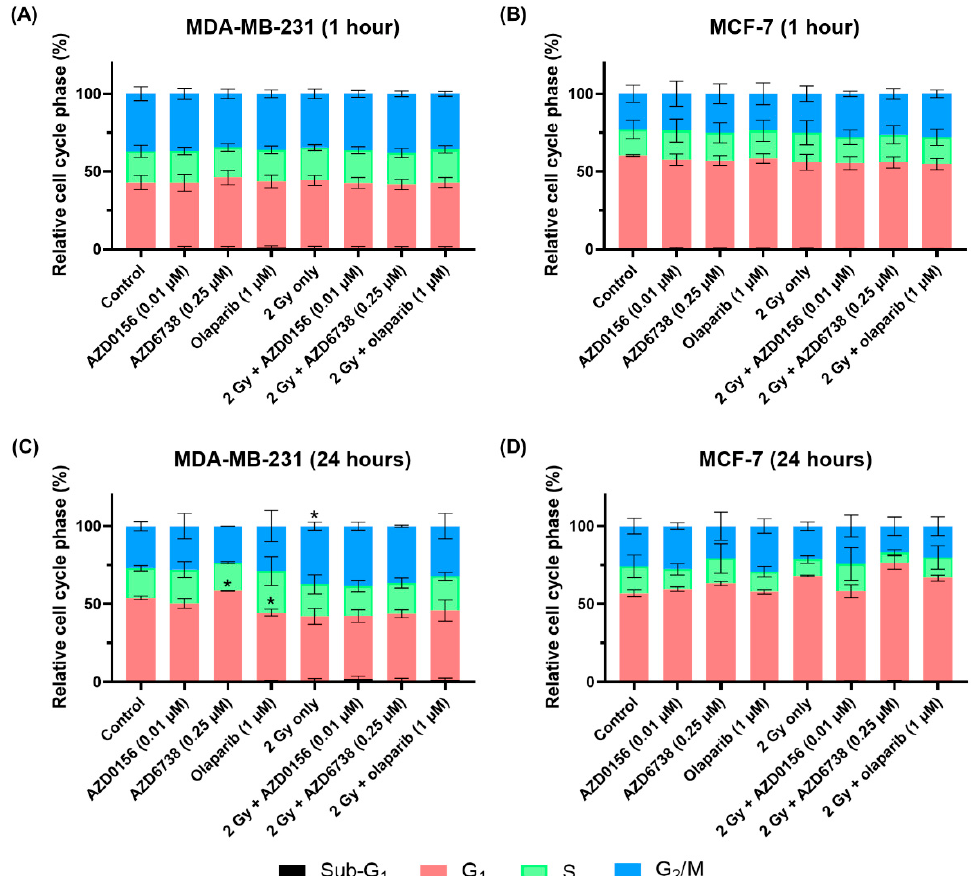
Figure 11. DDR inhibitors have minimal effect on cell cycle distribution of MDA-MB-231 and MCF-7 cells. MDA-MB-231 and MCF-7 cells were treated with 2 Gy IR, a DDR inhibitor, or combinations of both, then cell cycle analysis was performed after ( A , B ) 1 and ( C , D ) 24 h using flow cytometry. Data shown as mean ± SD of at least two independent experiments, with at least 5000 cells analyzed in each sample. * p < 0.05 vs. control.